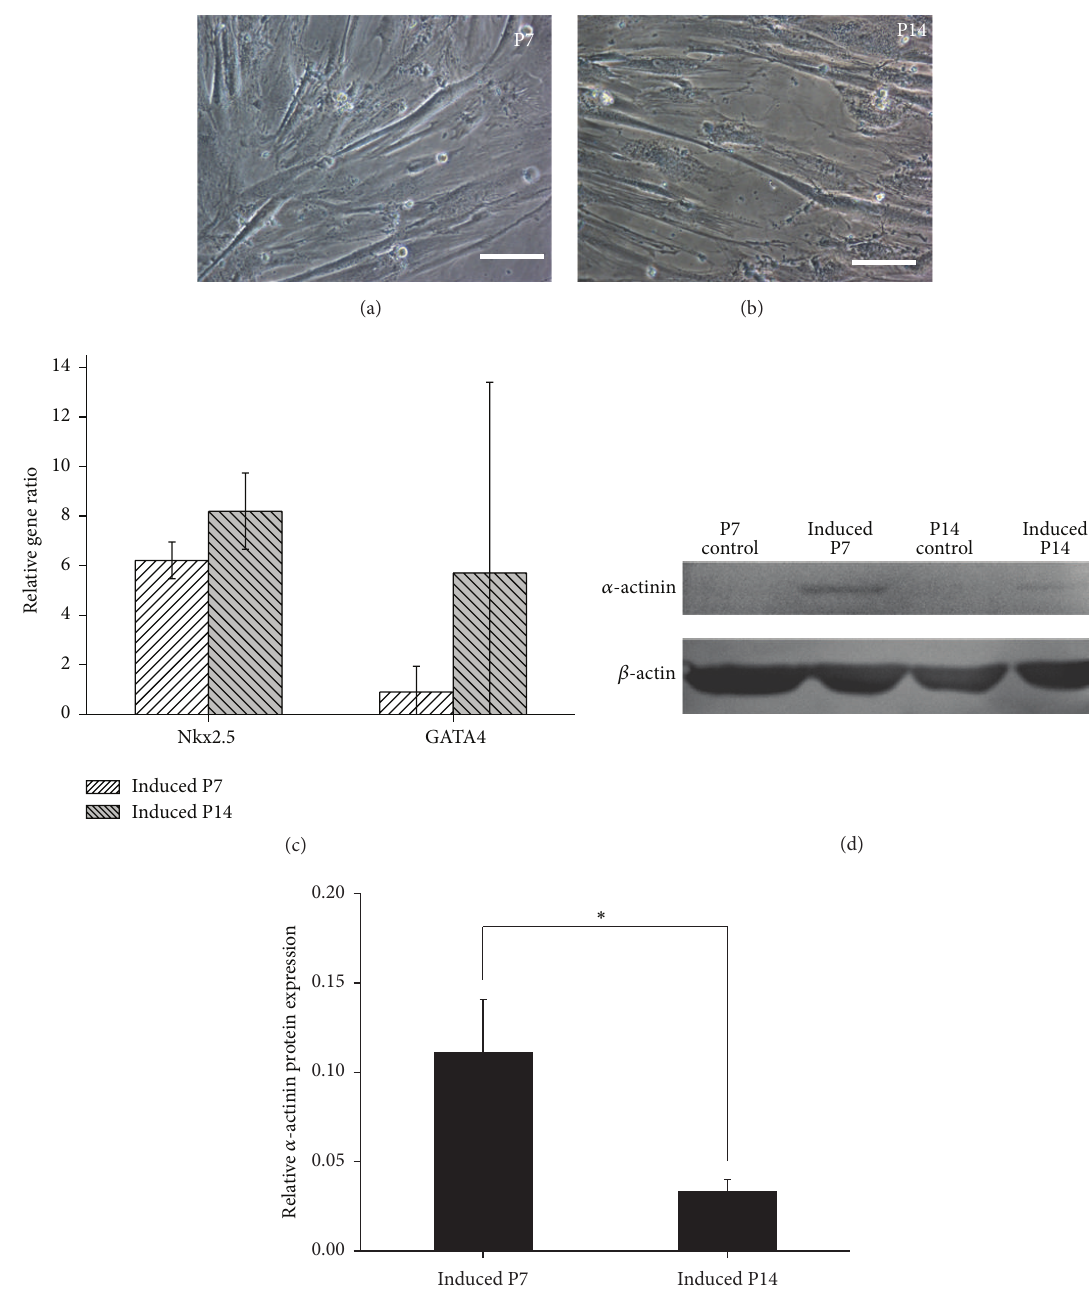
Figure 5: Morphology and expression of cardiac-specific genes and protein in WJ MSCs (Wharton’s jelly-derived mesenchymal stem cells) in the early and middle phases after cardiac induction. (a-b) After being treated with 5-Aza for 14 days, cardiomyocyte-like cells with a stick- like morphology were found in induced P7 and P14 cells. Bar: 100 𝜇 m. (c) The gene expression of GATA4 and Nkx2.5 was upregulated after cardiac induction. (d) No 𝛼 -actinin protein expression was detected in normal P7 and P14 WJ MSCs (P7 control and P14 control). However, 𝛼 -actinin protein expression appeared in the induced cells (induced P7 and induced P14). (e) Semiquantified analysis of western blot results showed that 𝛼 -actinin protein expression in the group of induced P7 was significantly higher than induced P14 ( ∗ 𝑃 < 0.05 ), which indicated that serial passage significantly decreased the cardiac differentiation capability of WJ